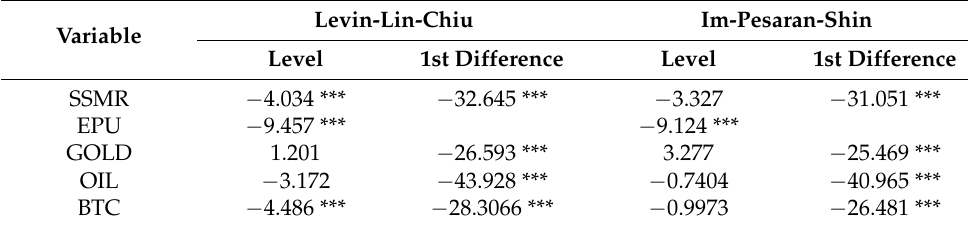
Table 4. Panel Unit Root Test Results.